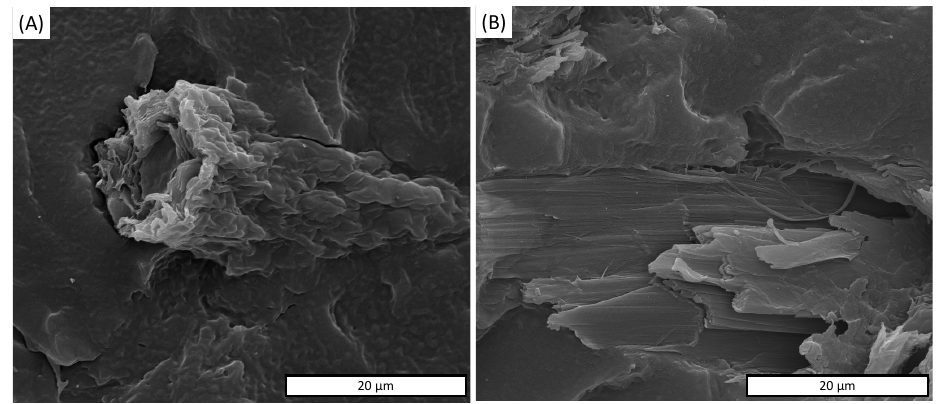
Figure 6. SEM images of the fractures surface of ( A ) PBAT/as-MCC 20%, ( B ) PBAT/c-MCC 20%.